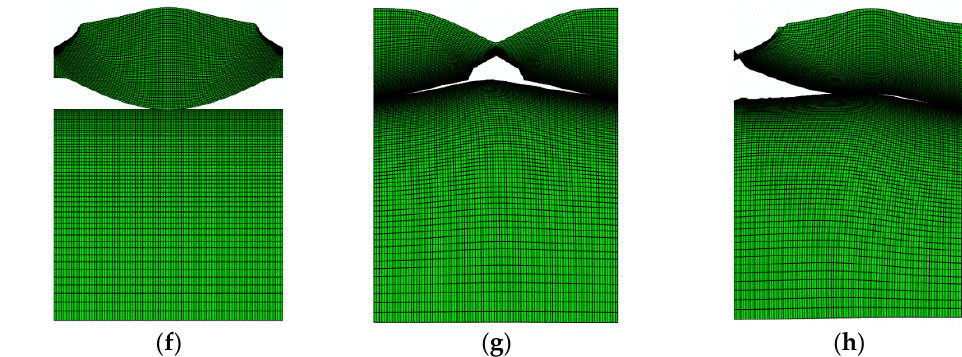
Figure 8. Failure mode of the laminate for two different wavelengths of ( a – d ) h/2 and ( e – h ) 2 h, ( a , e ) without roughness, ( b , f ) roughness on Al foil surface, ( c , g ) roughness on LDPE surface and ( d , h ) roughness on both layers.